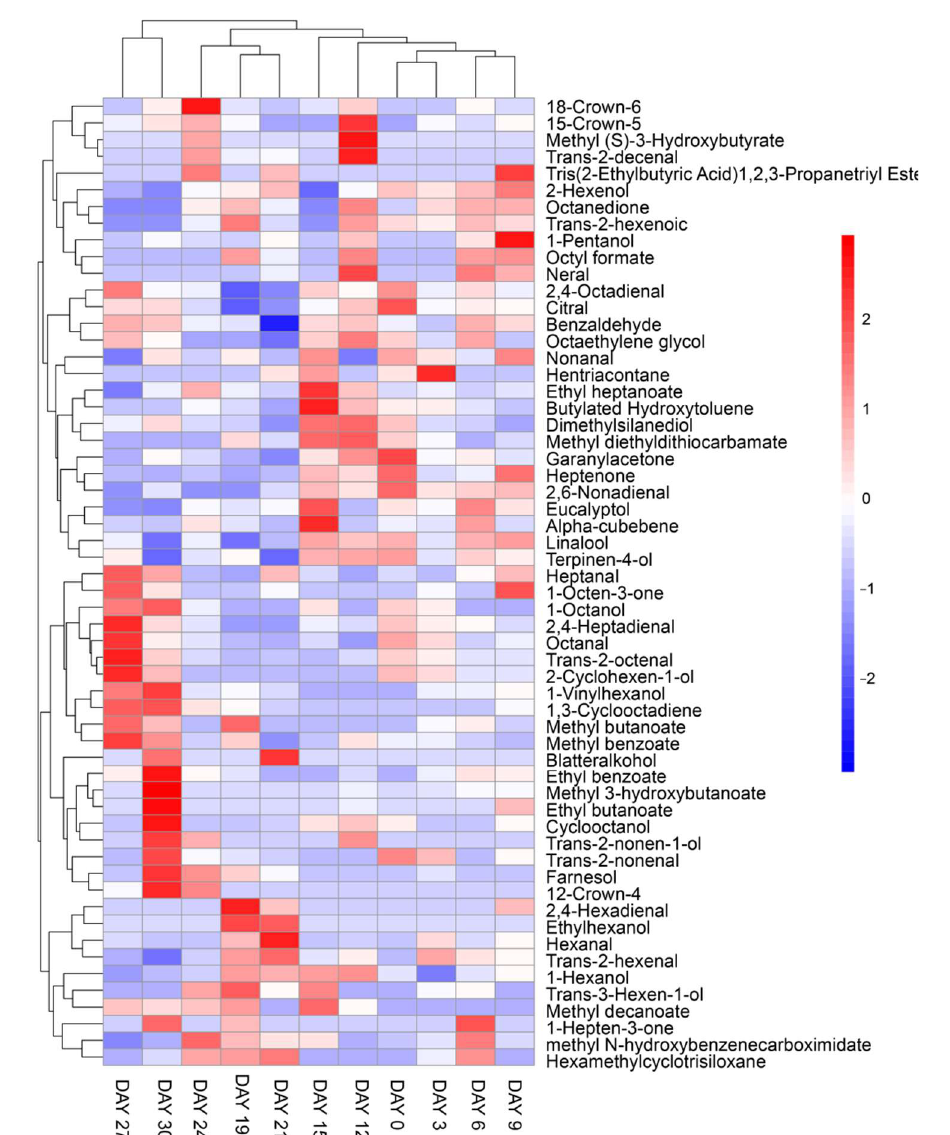
Figure 4. Heatmaps of volatile flavor compounds of ‘Xuxiang’ kiwifruit.